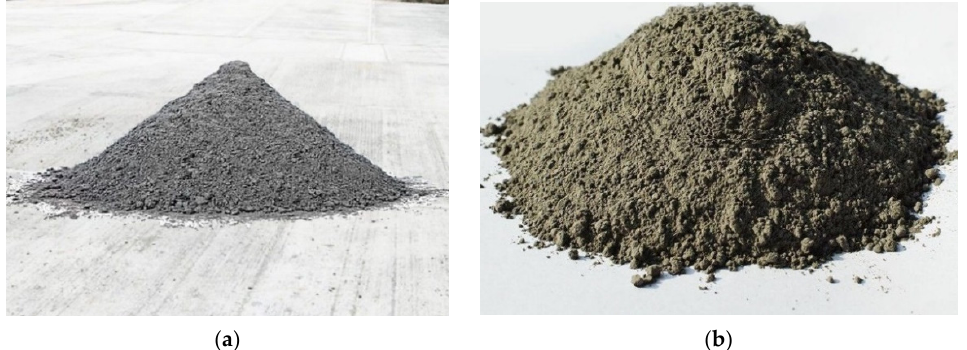
Figure 1. Appearance of the dusts: ( a ) clinker, and ( b ) aspiration. Liquid glass such sodium metasilicate Na 2 SiO 3 was used as the binder modifier (sili- cate modulus of 2.8 and density of 1.42 g/cm 3 ). Sodium hydroxide NaOH was used as an alkali. To accelerate the hardening process of the AAM, sodium fluorosilicon Na 2 SiF 6 was